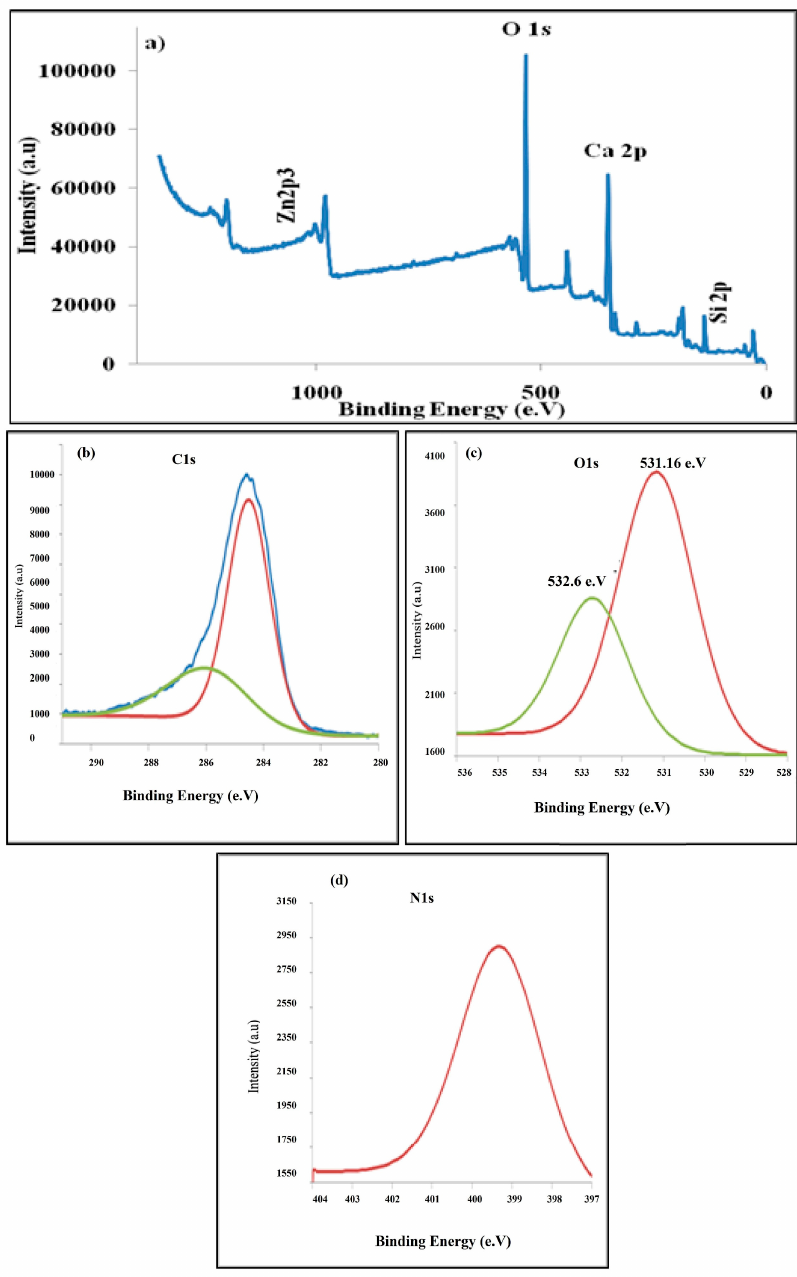
Figure 14. XPS spectra of the PANI / ZnO nanocomposite: ( a ) full survey, ( b ) C1 s , ( c ) O1 s and ( d ) N1 s